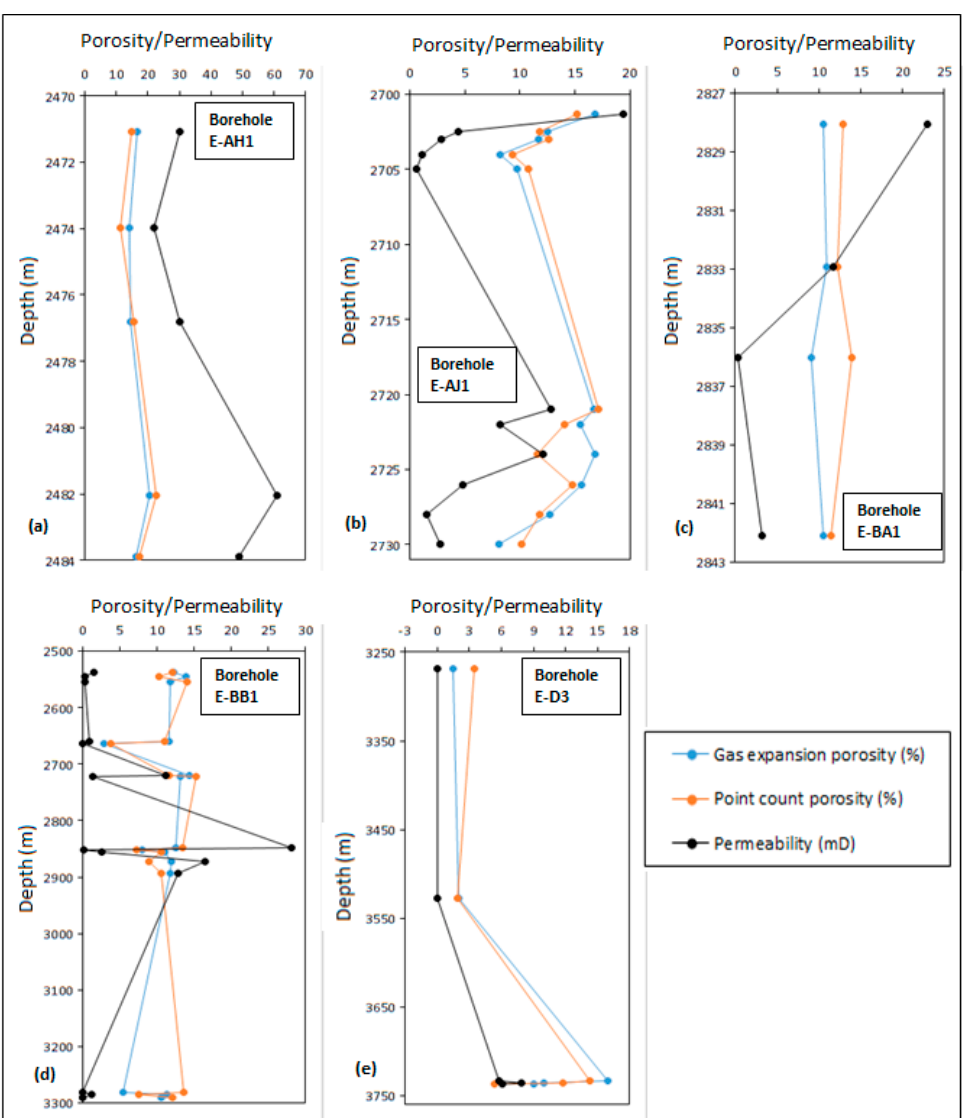
Figure 9. Downhole point count porosity, Poroperm Porosity and permeability for exploration wells: ( a ) E-AH1; ( b ); E-AJ1; ( c ); E-BA1; ( d ) E-BB1; ( e ) E-D3.